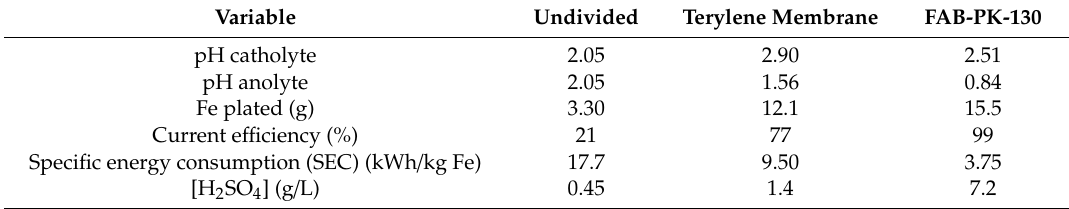
Table 4. Comparison of data obtained after 5 h with the three EW